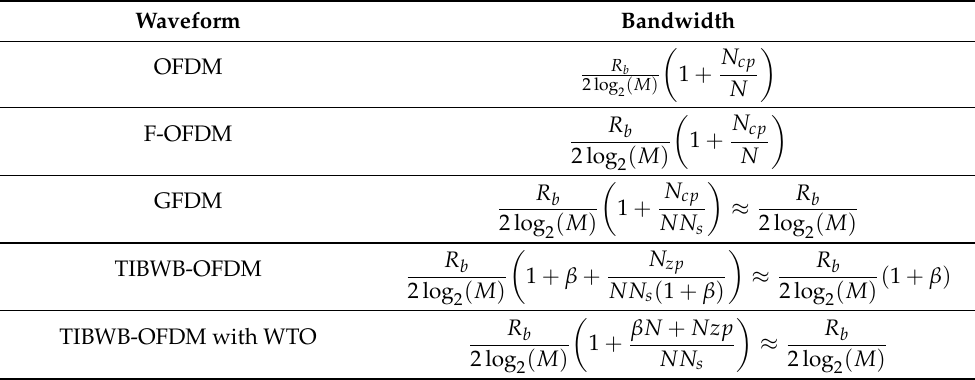
Table 1. Required bandwidth for the different